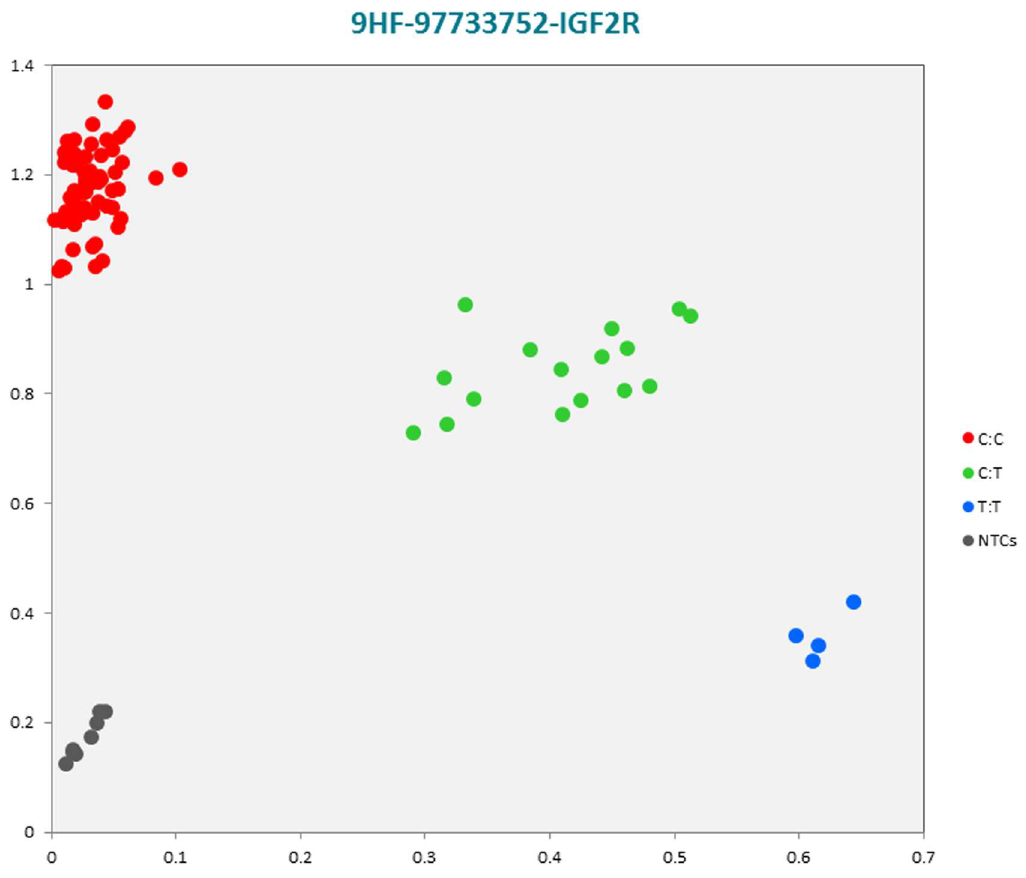
Fig 6. KASP TM SNP genotyping assayof BTA9_97733752 locus of Polish HF IGF2R gene showing the data for single KASP TM assayson a single cluster